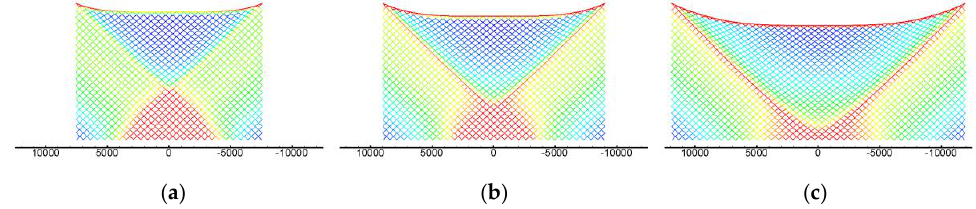
Figure 10. Distribution of tension force on the trash-blocking nets for different net widths: ( a ) W =15 m; ( b ) W =18 m; and ( c ) W =24 m.